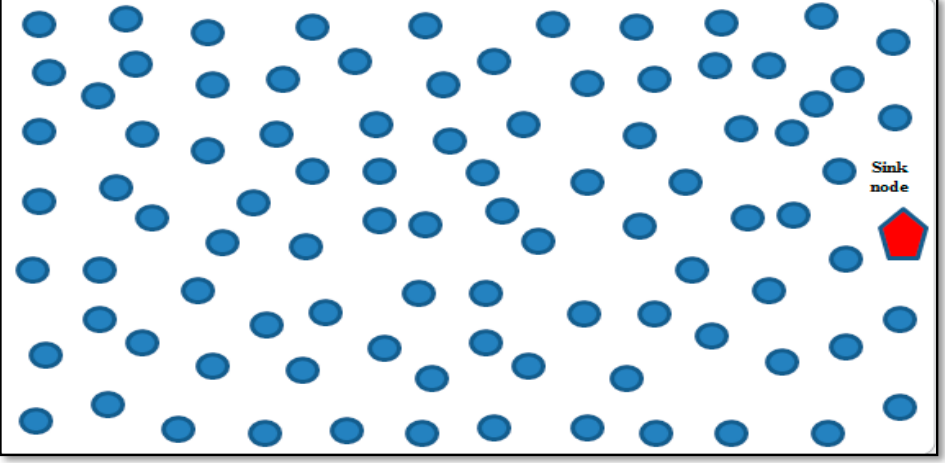
Table 1. The symbols and explanation.